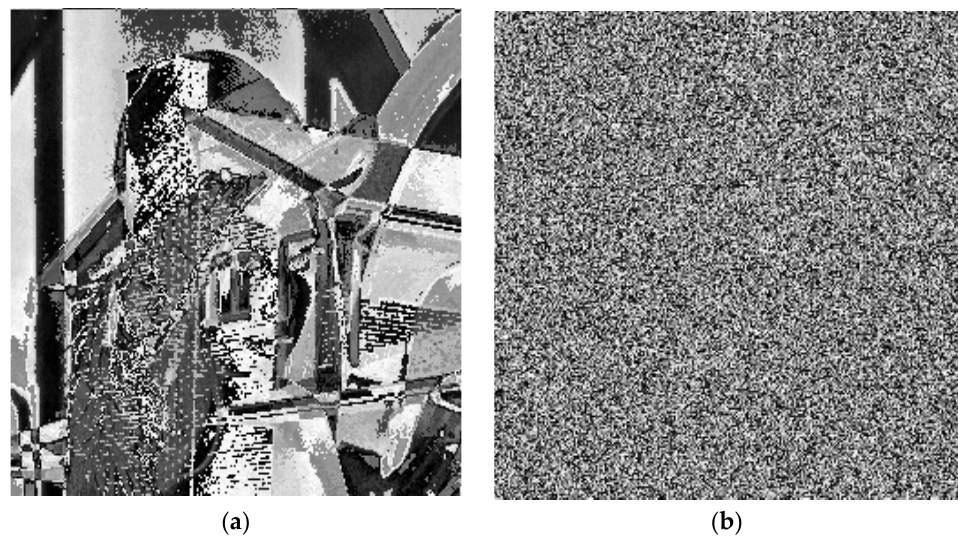
Figure 9. ( a ) P1 ⊕ P2; ( b ) E1 ⊕ E2.